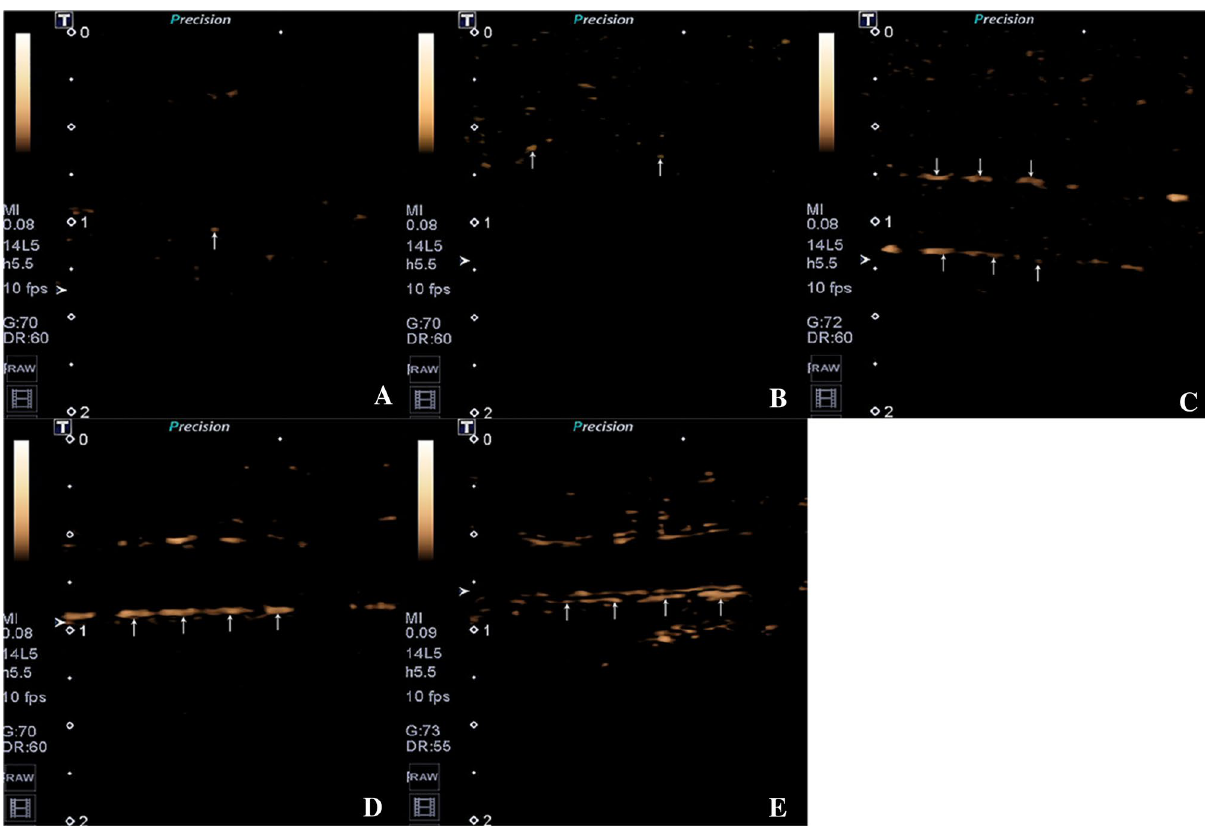
Figure 4. ICAM-1-targeted nano ultrasonic contrast images of abdominal aorta of experiment rabbits in different groups, five rabbits in each group. ( A ) Control group; ( B ) Week-4 group; ( C ) Week-8 group; ( D ) Week- 12 group; ( E ) Week-16 group. The vascular wall was indicated by the